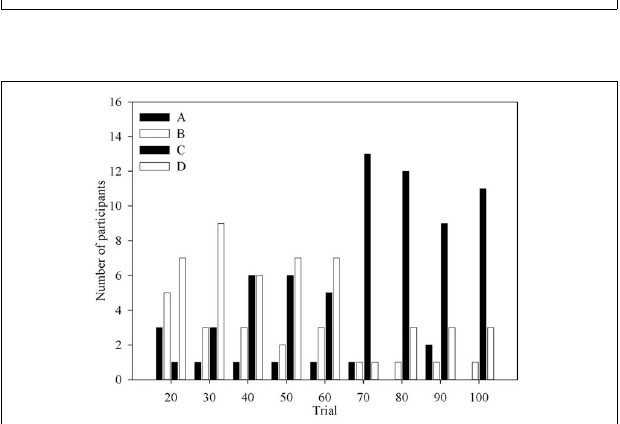
FIGURE 3 | The number of participants at each question period who selected each deck as the One Deck they would choose if forced to only pick from